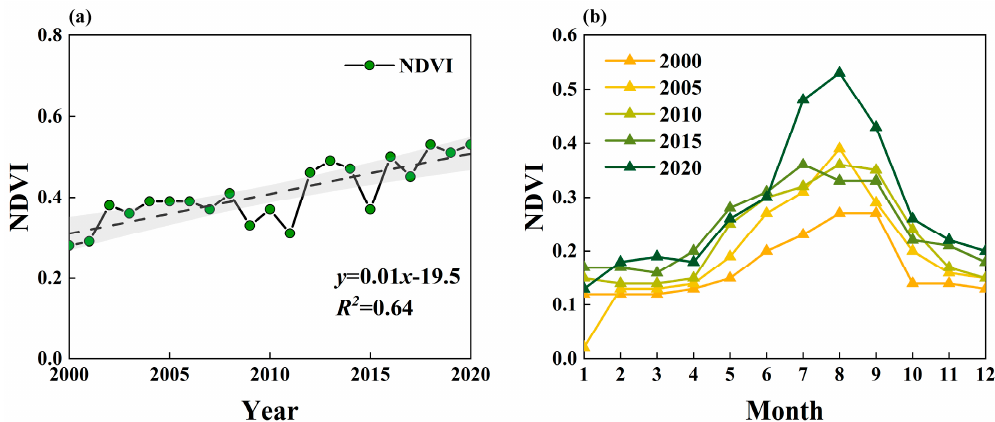
Figure 4. ( a ) Trend of inter-annual variation of NDVI in the Huangfuchuan Watershed from 2000 to 2020, and ( b ) trend of intra-annual variation of NDVI in the Huangfuchuan Watershed in 2000, 2005, 2010, 2015, and 2020.